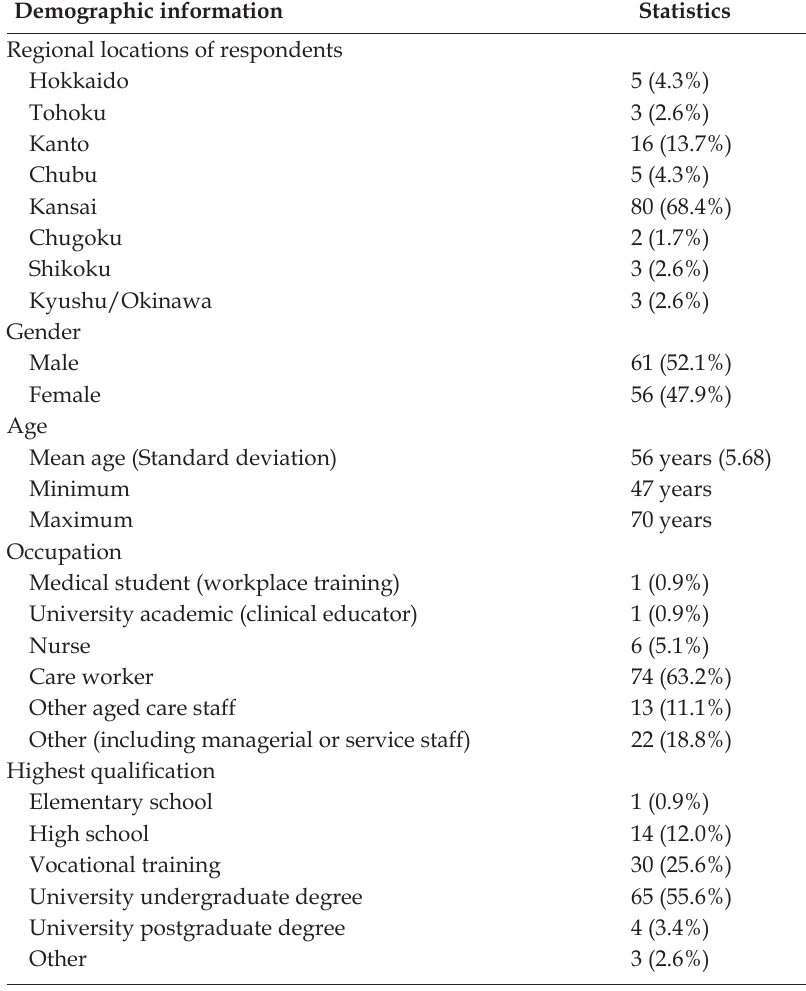
Table 1. Demographic profile of respondents ( N =